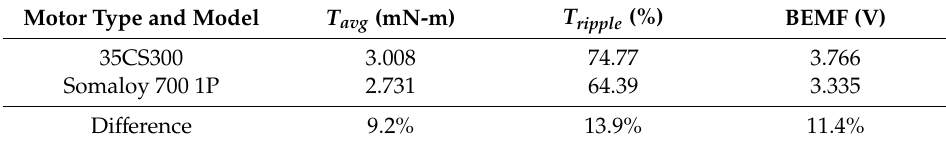
Figure 6. BEMF-angle curves of ( a ) 35CS300 and ( b ) Somaloy 700 1P motors at a rotational speed of 9000 RPM. Table 4. Theoretical properties of 35CS300 and Somaloy 700 1P motors .